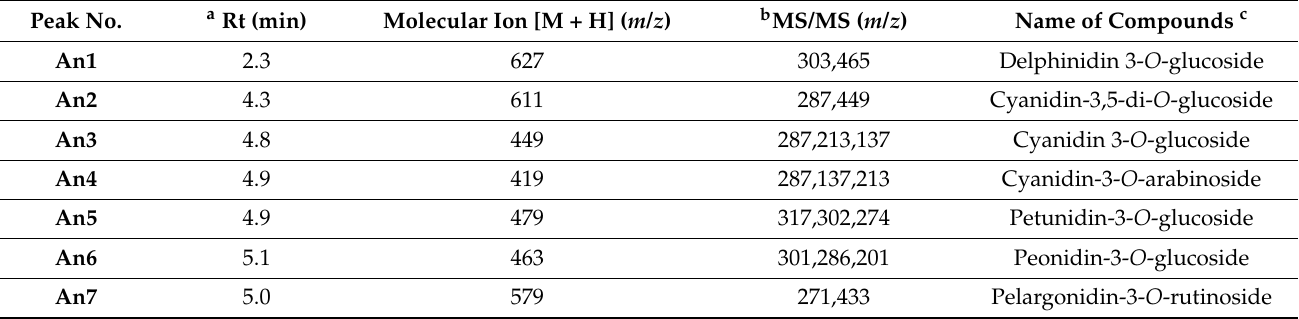
Table 6. Anthocyanins identified by HPLC-ESI-MS n in Mortiño